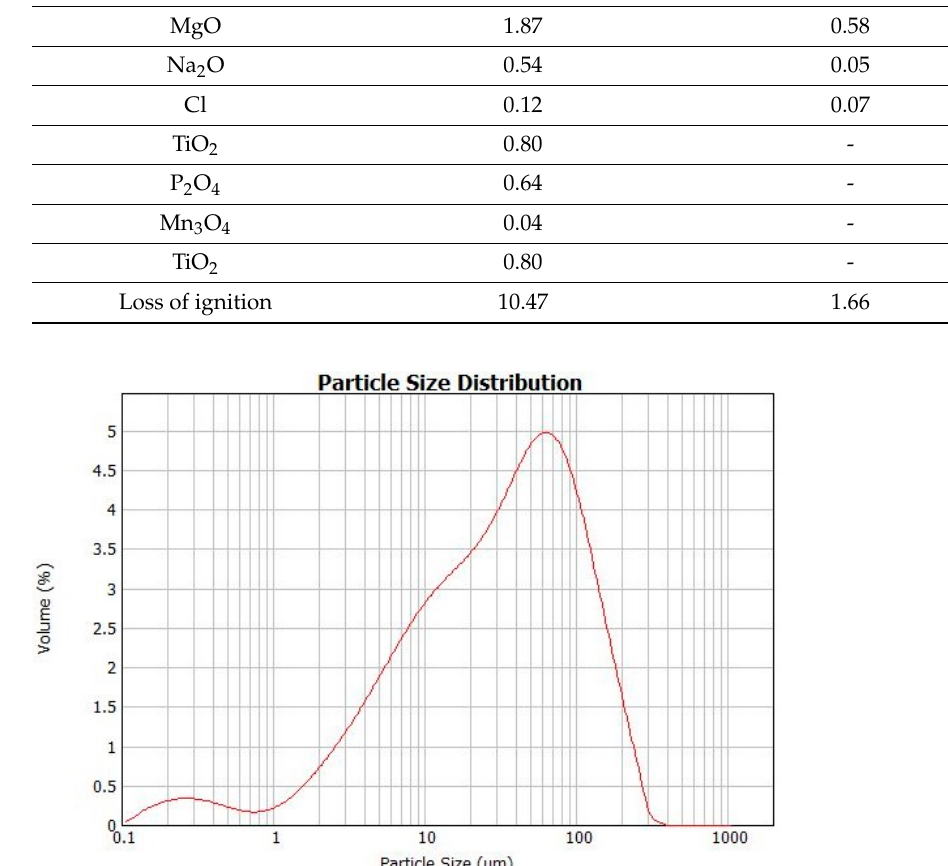
Table 2. Chemical composition of fly ashes and cement .